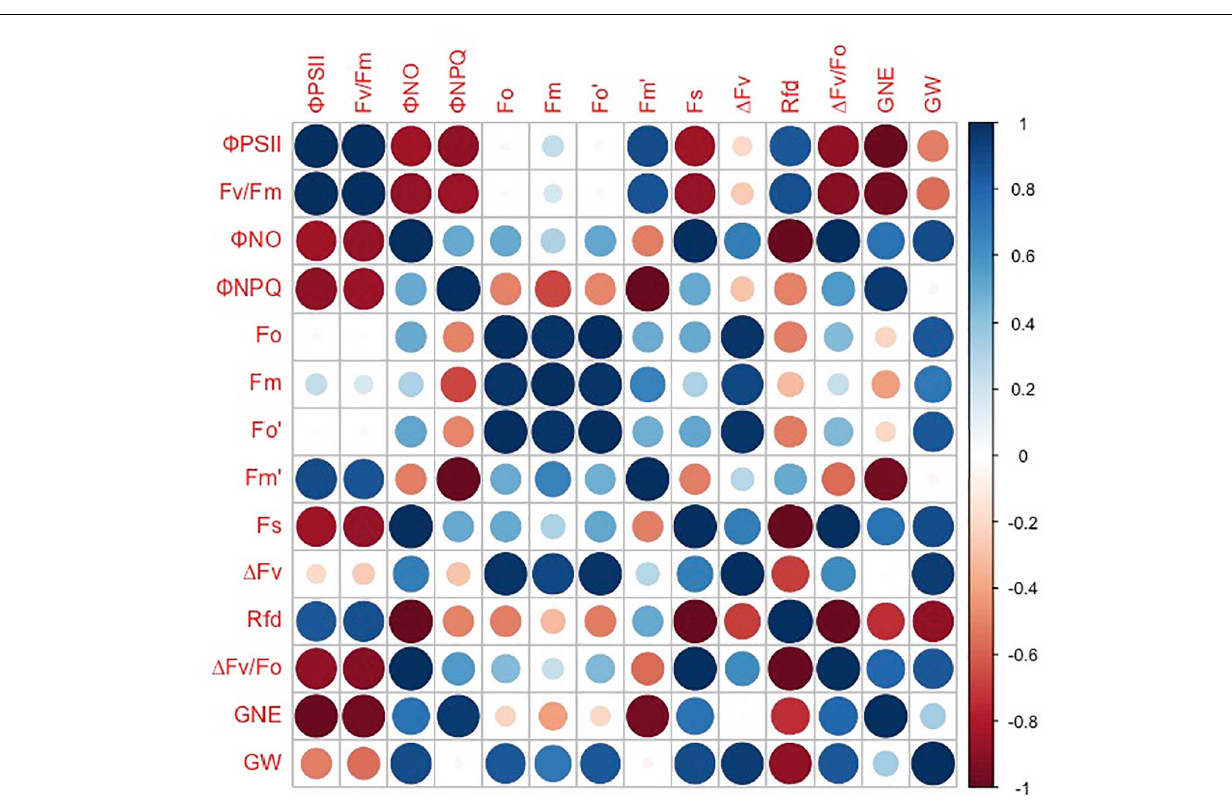
Frontiers in Plant Science |